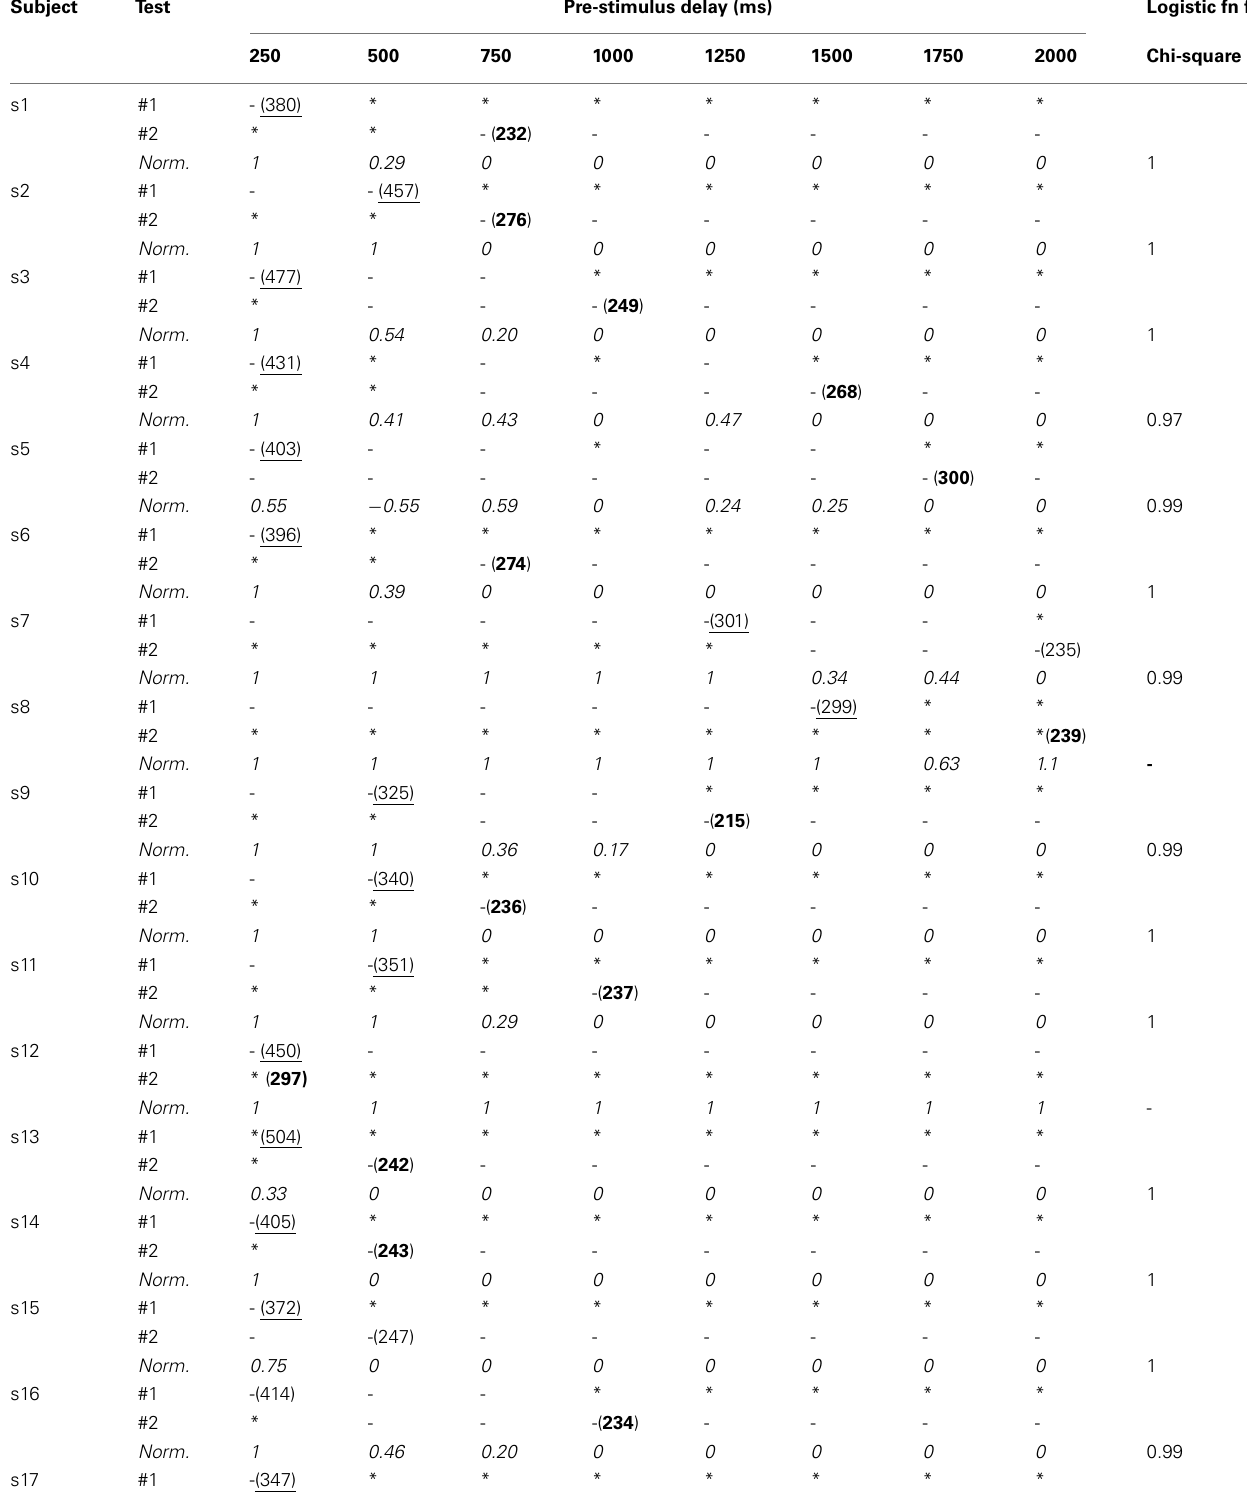
Table 1 | Individual RT analyses of Experiment